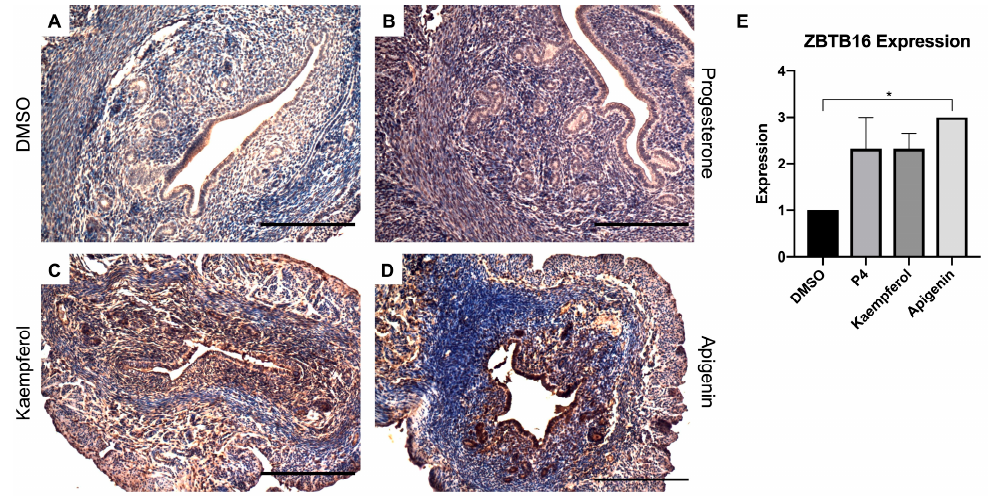
Figure 2. Kaempferol and apigenin increased ZBTB16 expression in mouse uteri. Immunohistochem- ical staining against progesterone receptor target ZBTB16 on uterine cross sections of control- ( A ), progesterone- ( B ), kaempferol- ( C , D ) apigenin-treated mice. Scale bar = 100 µ m; magnification 20 × . ( E ) Quantification of ZBTB16 expression per treatment in representative images. One-way ANOVA test was used to determine significance (* p < 0.05).